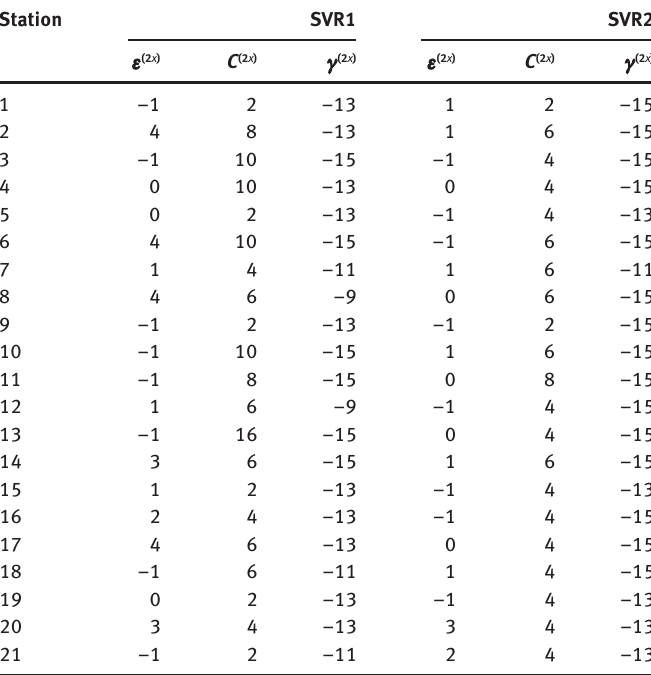
Table 3: Optimized Values of SVM Model Parameters for Different Stations. Station